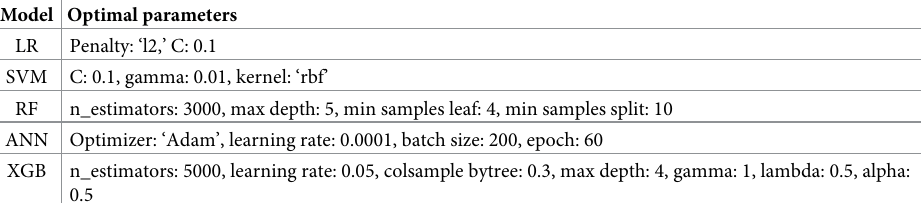
Table 1. Optimal parameters for each machine learning model are selected through the grid search. Model Optimal